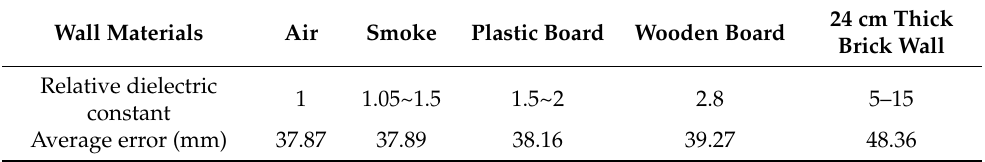
Table 4. Pose reconstruction error through the different wall